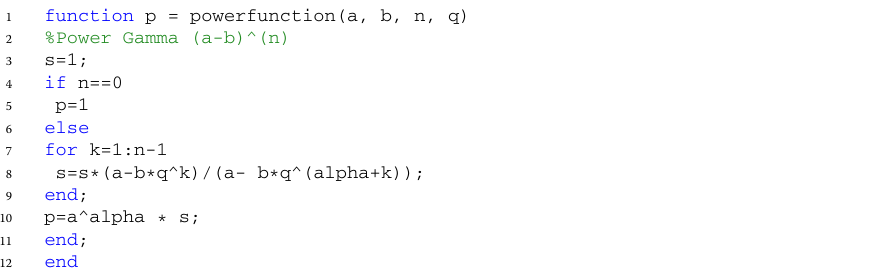
Algorithm 1 The proposed method for calculated ( a – b ) ( α ) q